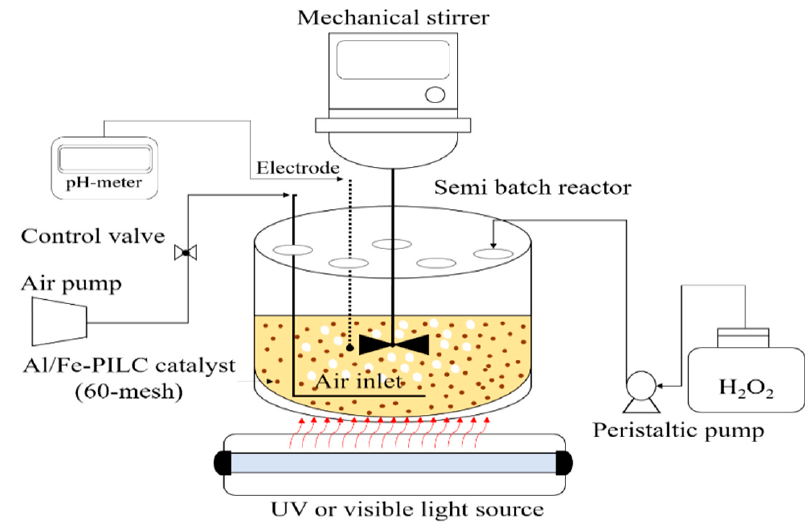
Figure 7. Experimental setup used in the CWPO photocatalytic tests for NOM/phenol degradation. PLL18W Philips lamp provided UV irradiation ( λ : 365 nm), irradiance power of 6 mW/cm 2 ; LED lamp (with a small fan for temperature control) provided visible irradiation (steepest wavelength at 450 and 550 nm), irradiation power 160 mW/cm 2 .